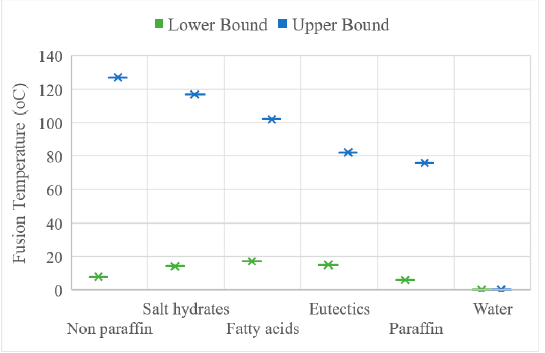
Figure 11. Fusion temperature for different phase change material (PCM) types (adopted from [30]).